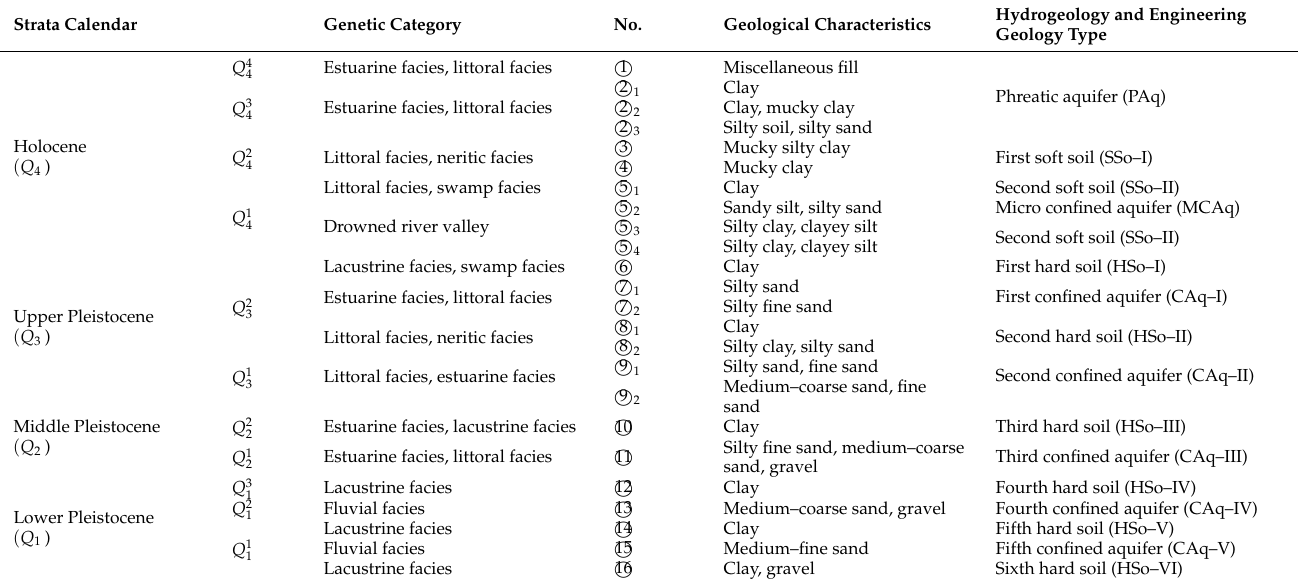
Table 1. Engineering geological characteristics in